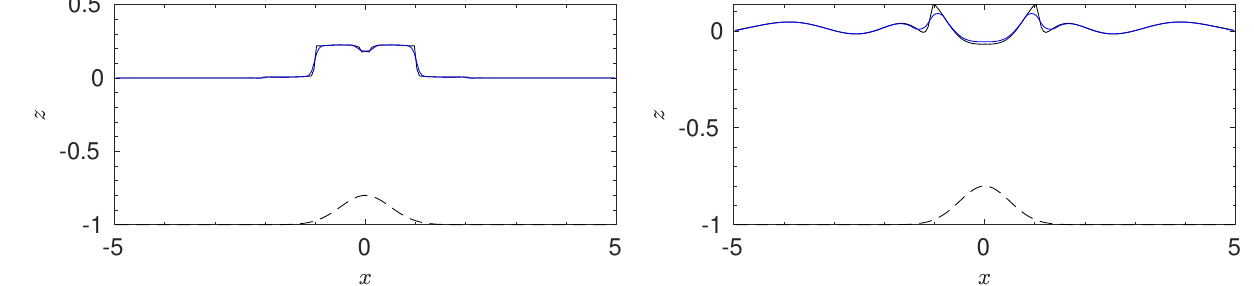
Figure 15. Cross section at y = 0 of the computed free-surface for the problem (69) (dispersive Gavrilyuk–Favrie equations) at time t = 0.1 s ( left ) and t = 5 s ( right ) with the fourth order limited (blue) and non-limited (black) Runge–Kutta DG method. A uniform Cartesian mesh of N x × N y = 200 × 200 elements has been used. Dashed lines stand for the bottom topography H